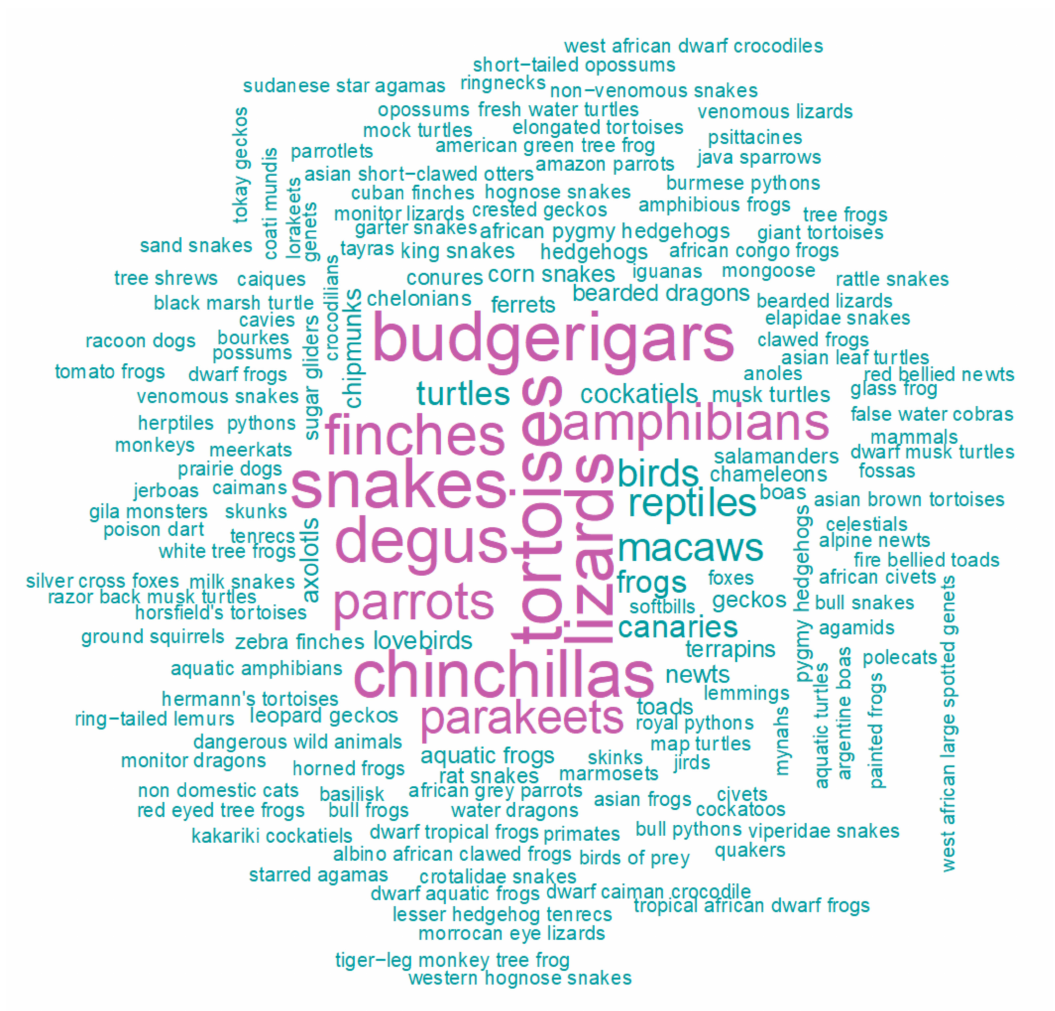
Figure 2. Word frequency cloud showing the wild animal listings across all pet shop licences. The size of the word indicates the frequency of listing. Listings above a frequency of 180 are coloured in